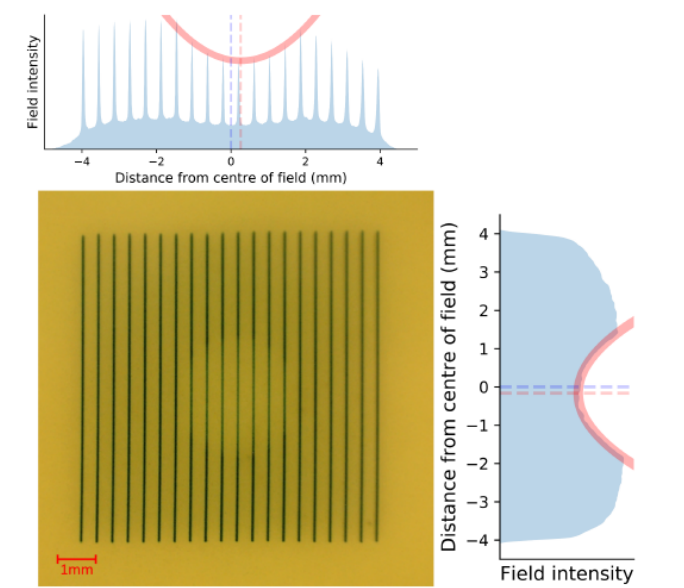
Figure 8. Film placed on the exit side of the phantom shows the circular ball bearing attenuating the square microbeam treatment field. Adjoining plots show the 1D intensity of the beam (blue) and a Gaussian fit of the beam intensity (red) with dashed lines indicating the centre of each